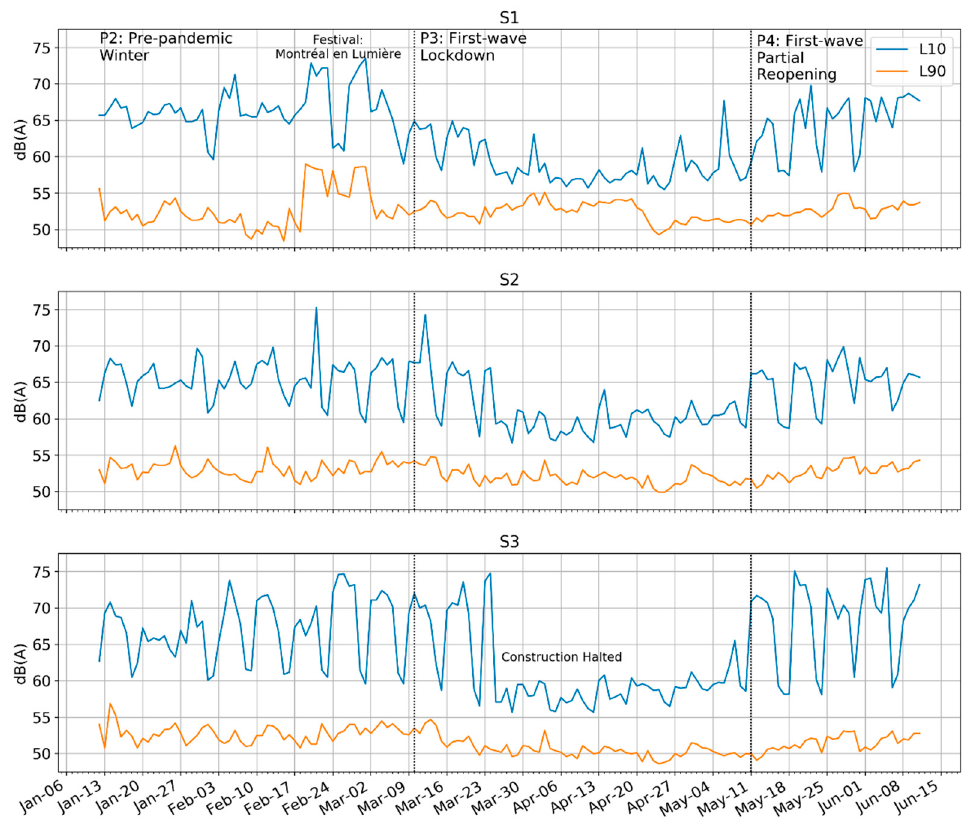
Figure 7. Comparison of background (L 90 ) and emergent (L 10 ) statistical indicators throughout the lockdown period (P3). Emergent sounds declined more than background sounds during P3; data from P2 and P4 are shown for context.